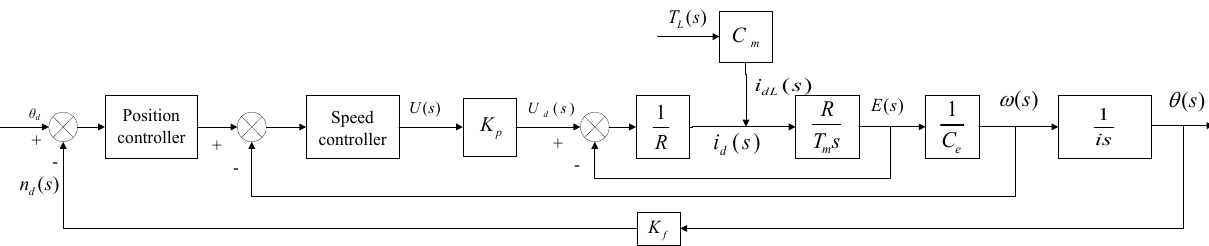
Figure 2. Block diagram of the open − loop transfer function of the EMA system.